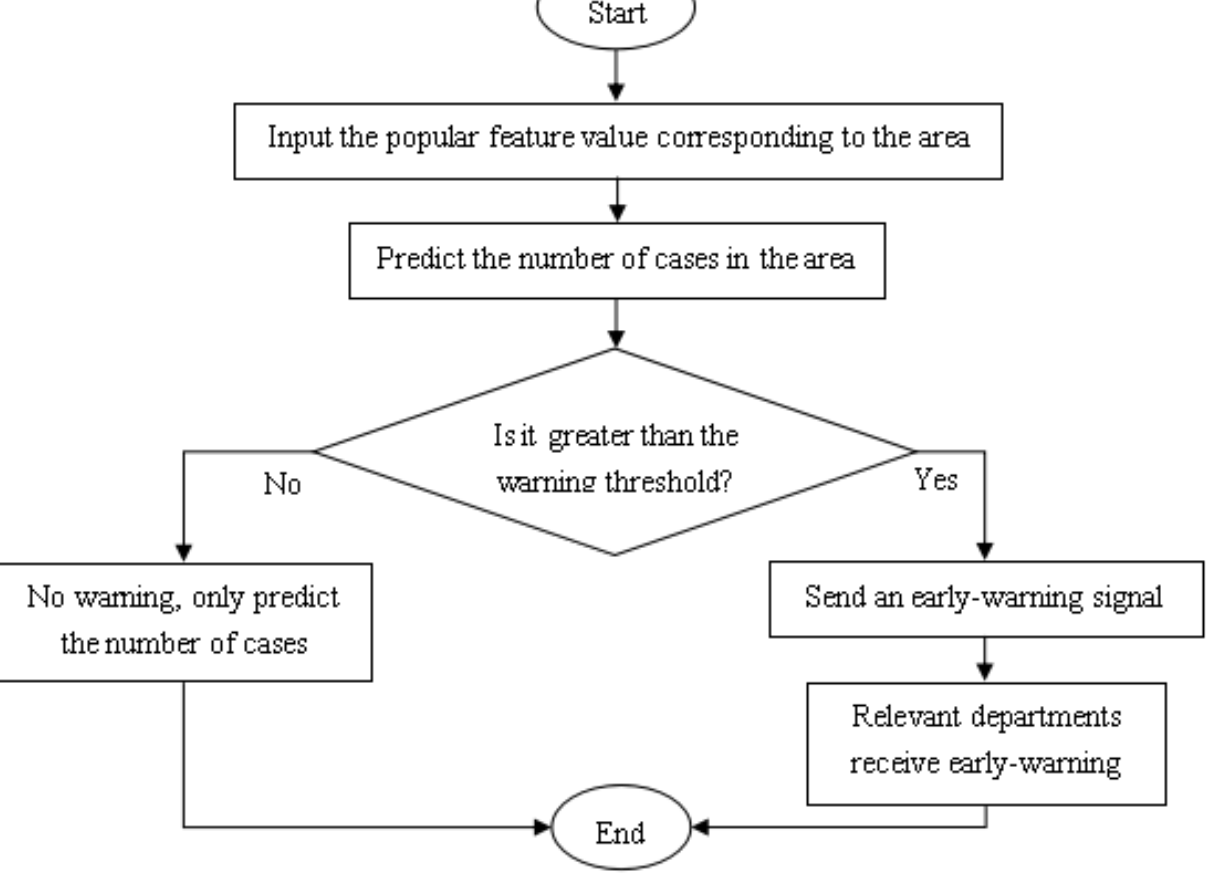
Figure 9. Flow chart of HFMD epidemic warning